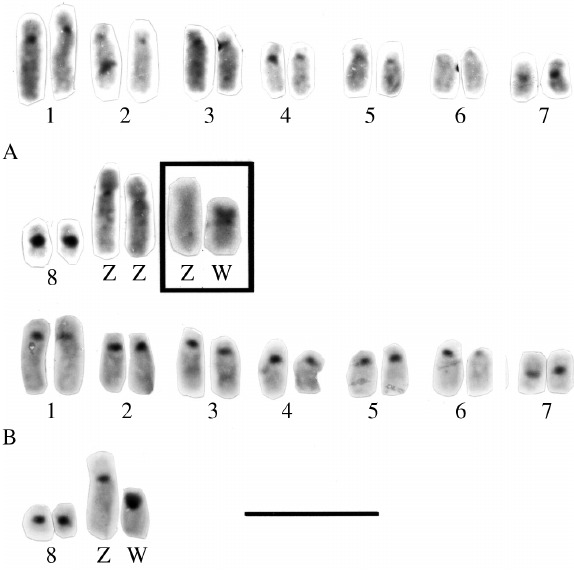
Figure 3 - C-banding patterns of the macrochromosomes of (A) a Graydidascalus brachyurus male and (B) a Salvatoria xanthops female. A G. brachyurus ZW female sex chromosomes is shown in the insert . Bar = 10 µ